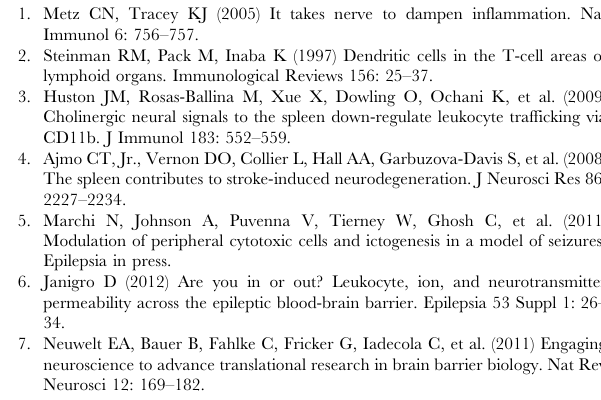
Figure S2 S100B levels in peripheral tissues are low at steady state and increase with rising serum S100B levels. The rat hepatic tissue shown demonstrates a level of labeling with injected AlexaFlour 488-tagged S100B proportional to the amount of protein administered; use of a 1:1 dilution (S100B to vehicle) produced more intense labeling ( L ) than that of a 1:10 dilution ( R ). Note that the staining produced by use of a lower concentration of S100B resembled that of the images obtained by immunohistochemistry of most peripheral tissues, suggesting that the lack of signal in the latter images is due to low or negligible levels of S100B at steady state in non-CNS tissues. Satellite cells ( boxes ) label strongly with high circulating levels of S100B, but staining also persists, albeit to a lower degree, in tissues exposed to a lower concentration. IV injection consisted of AlexaFlour 488- tagged S100B at either a 1:1 or 1:10 dilution with phosphate- buffered saline (PBS) introduced via tail vein and allowed to circulate 2–3 hrs. prior to tissue harvesting. (TIF) Figure S3 S100B uptake by CD86 positive dendritic cells in skin and spleen. ( A ) Skin cells demonstrating S100B uptake are Langerhans dendritic cells expressing CD86. ( B ) Spleen cells (shown as CD4 + and CD8 + in Figure 5), are dendritic cells expressing the marker of dendritic cell stimulation CD86. (TIF) Figure S4 Time- dependent uptake of S100B but not S100A1 by dendritic cells. The cells were first extensively characterized for expression of CD86, CD11a and CD83, markers of mature dendritic cells. Robust uptake, albeit in less than 20% of cells was seen. These results are essentially the same as those reported in vivo, but cultured cells were easier to study since they constitute an ideal tool for time-dependent analysis.